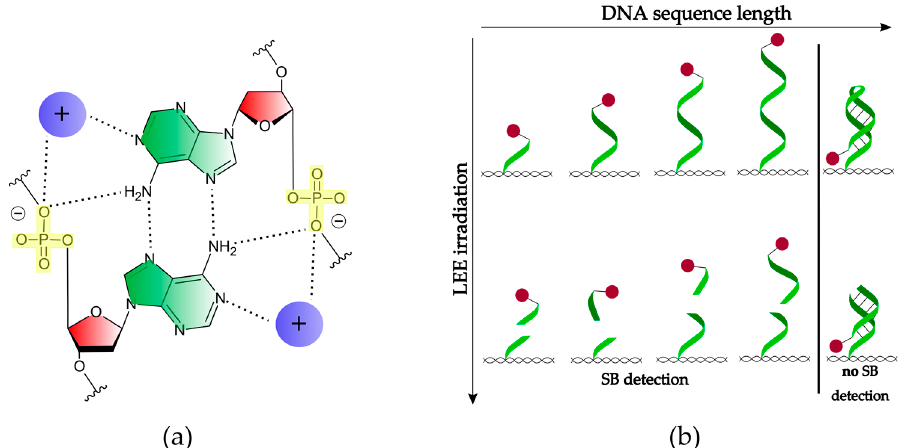
Figure 5. ( a ) Scheme of the A-A (green) base pair attached to the deoxyribose sugar unit (red) that builds the poly(A) duplex in the presence of cations (purple). The phosphate groups (yellow) are driven toward the axis of the helix and form two of the total four hydrogen bonds (dotted lines) [25]. ( b ) Scheme of the conformational change of a single-stranded DNA with increasing length and SB formation. DNA origami is depicted as a pattern in black, the biotin label as a spot in red, and the hydrogen bonding is labeled as a solid line in black.